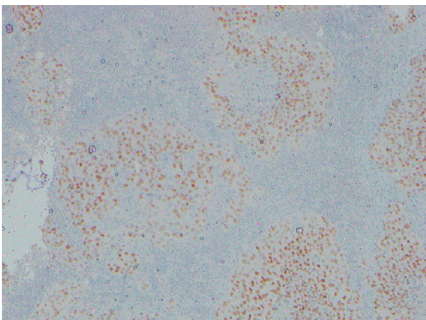
Figure 4: Immunohistochemistry of lymph node biopsy is positive for thyroid transcription factor 1 (TTF-1) confirming metastasis from an adenocarcinoma of lung.